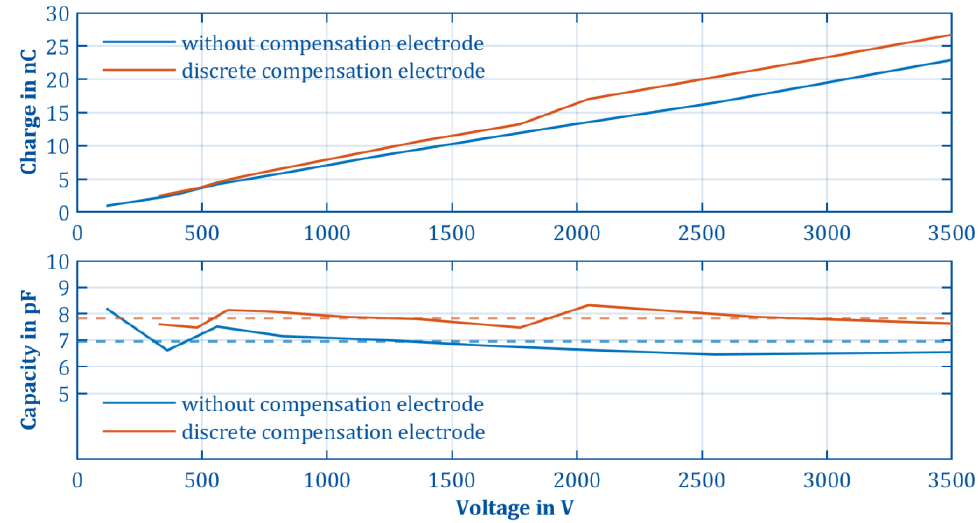
Figure 14. Measured charge ( top ) and calculated capacitance ( bottom ) for the resistive voltage divider without compensation electrode in blue and with discrete compensation electrode in red. In addition, the averaged values for the calculated capacitances of 6.95 pF without compensation and 7.83 pF with discrete compensation are shown by red and blue dashed lines.